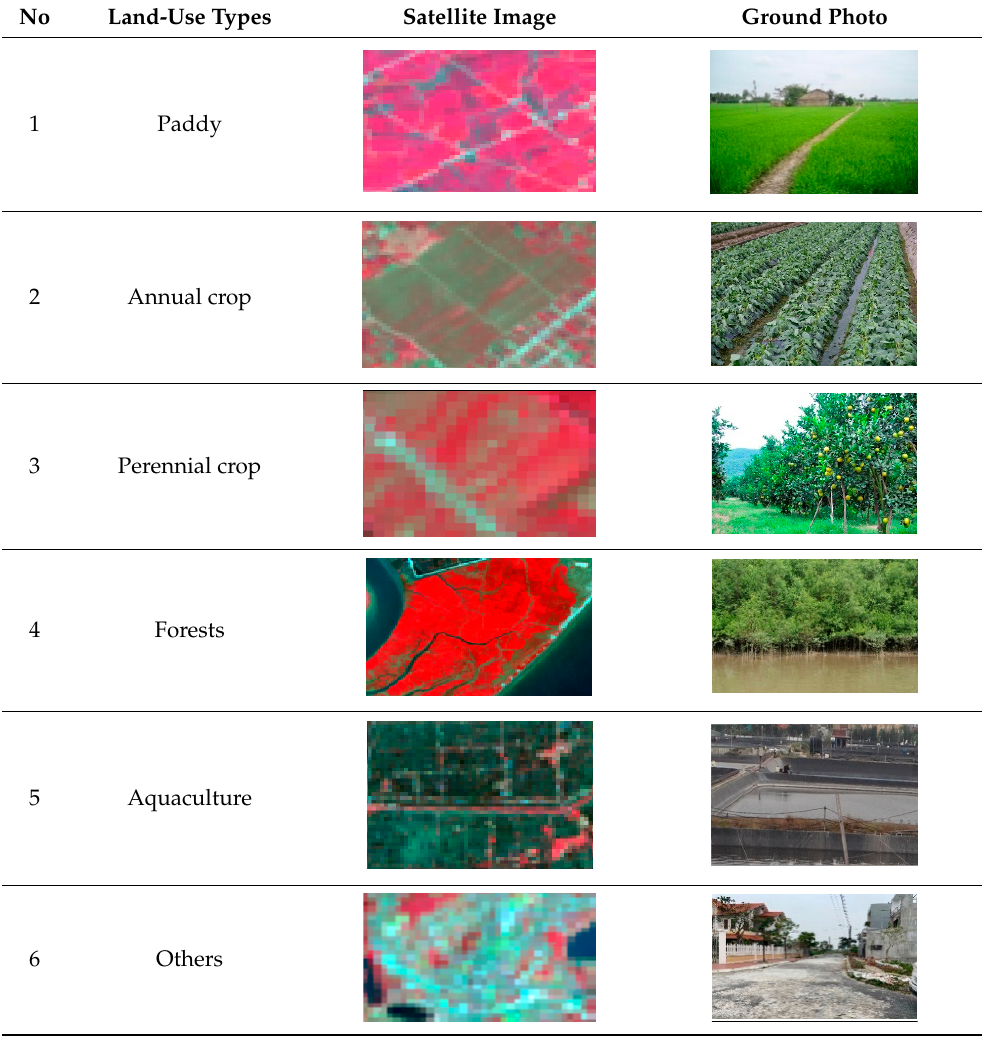
Table 2. Satellite image interpretation keys.